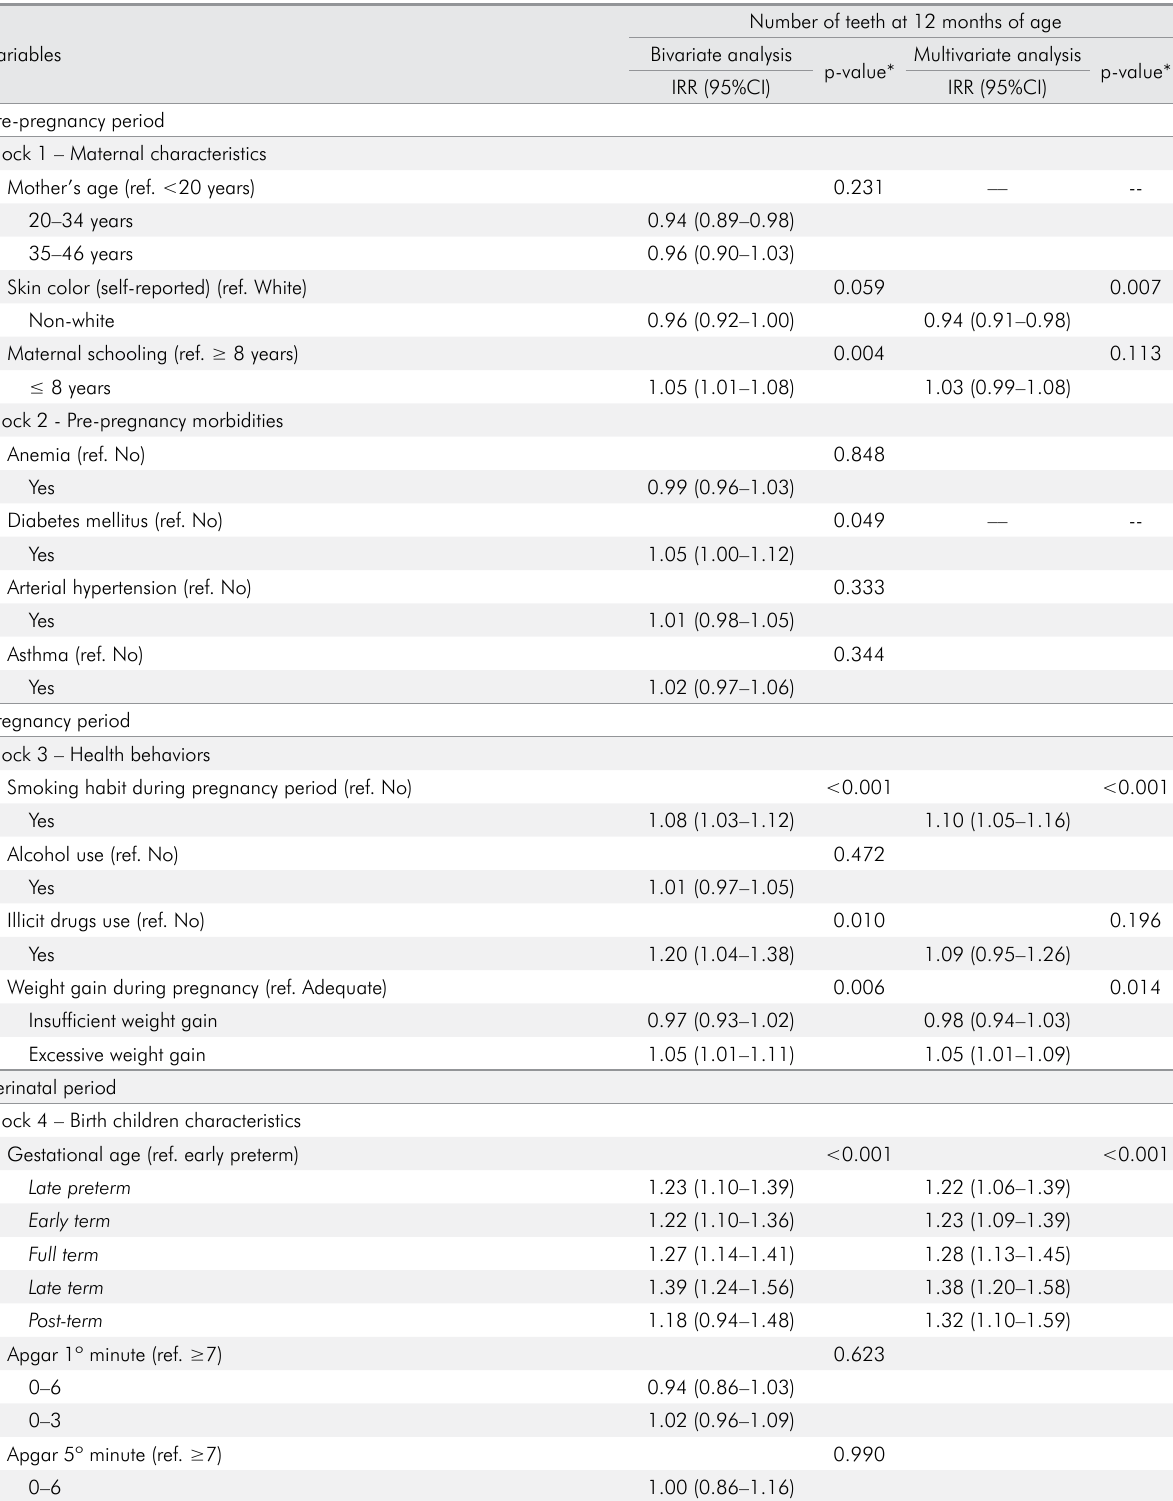
Table 2. Association between number of teeth at 12 months of age and independent variables considering socioeconomic and demographic characteristics, anthropometric measures and health behaviors in children population. Multivariate analysis: Poisson Regression. Pelotas, RS, Brazil (n = 4,014